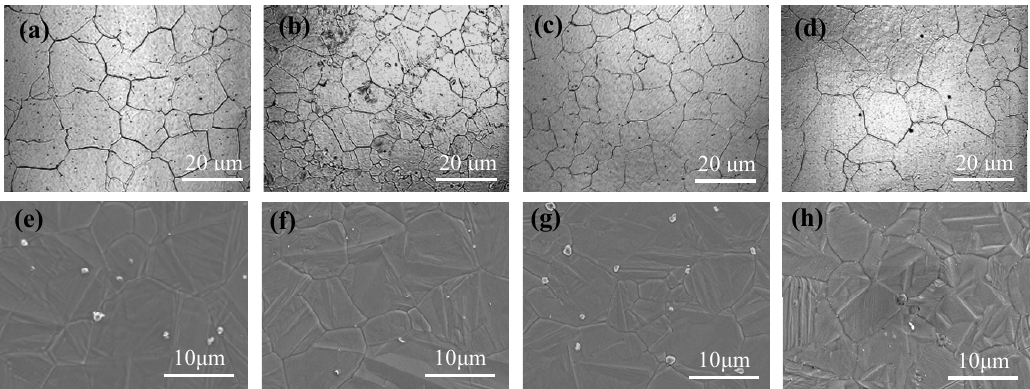
Figure 5. CLSM and SEM results of the samples heated for 10 min at 1050 °C: ( a–d ) CLSM; ( e–h ) SEM; ( a , e ) C1; ( b , f ) C2; ( c , g ) C3; and ( d , h ) C4.